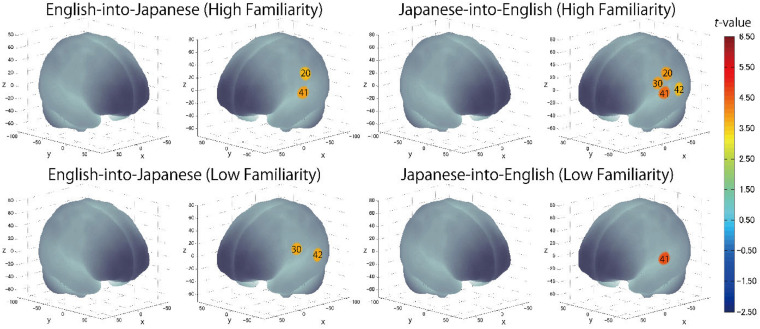
The results of the group analysis for the elementary group. Family wise errors due to multichannel measurement were corrected using the Bonferroni method. Significant t-values for MNI-registered channels are indicated by the color scale.